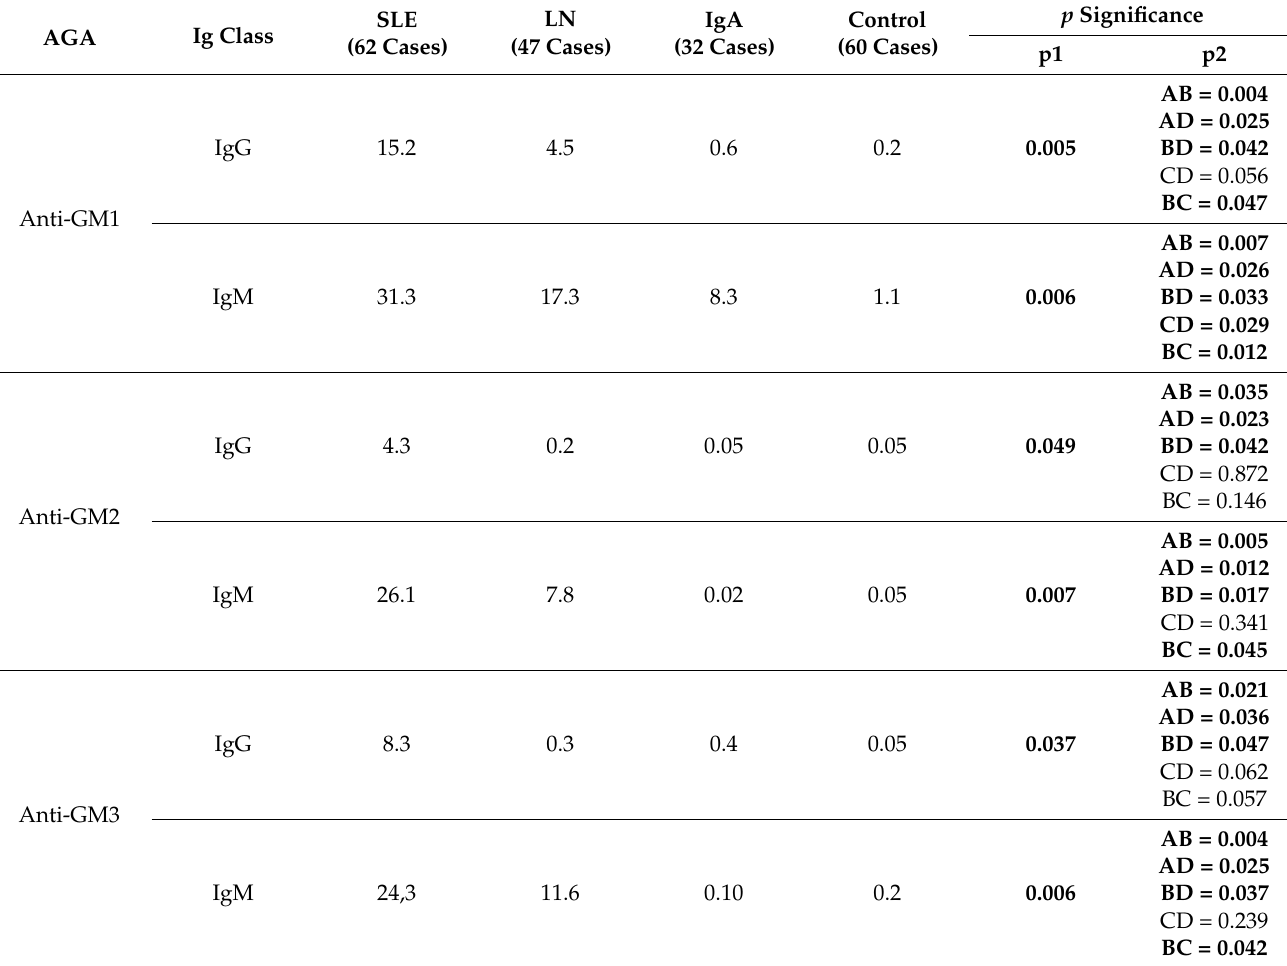
Table 5. Antiganglioside antibodies pattern in the studied